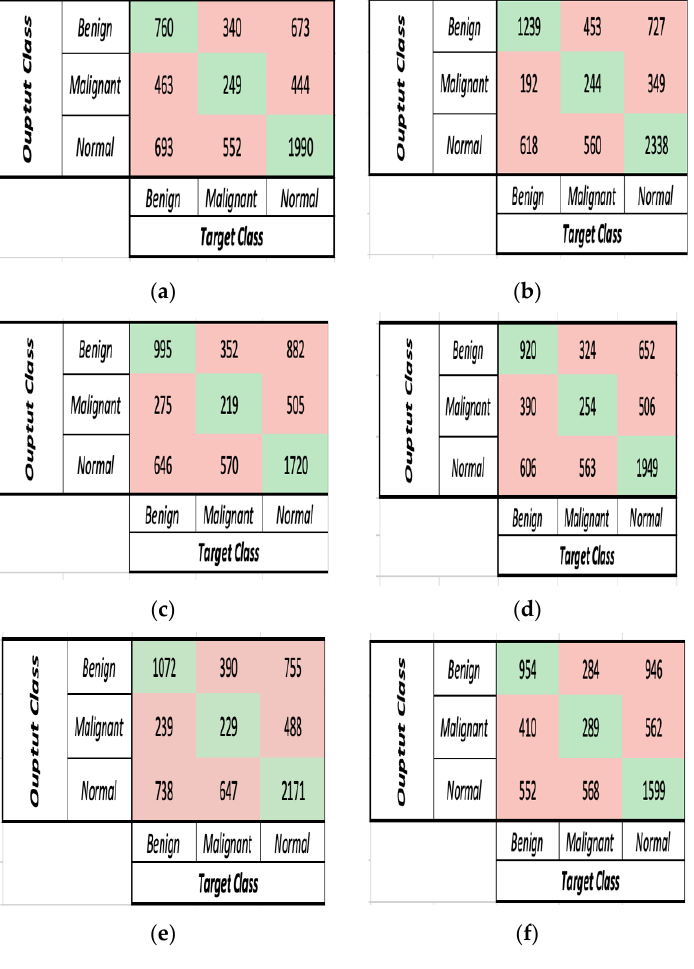
Figure 6. Confusion matrices on Dataset 1 after pre-processing for the DL models ( a ) ResNet-18, ( b ) AlexNet, ( c ) GoogleNet, ( d ) VGG-16, ( e ) MobileNetV2, ( f ) DenseNet-201.